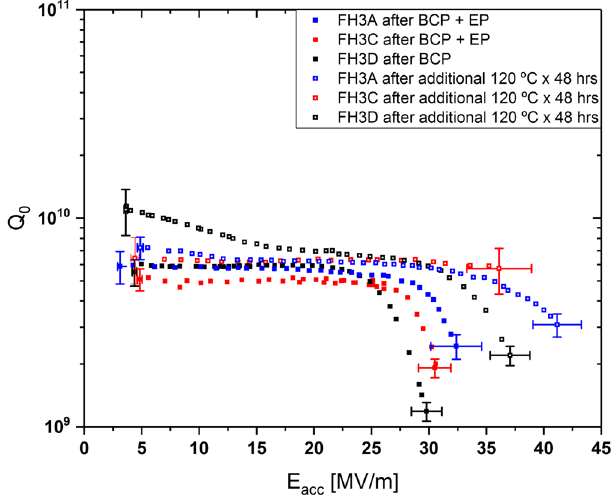
FIG. 9. FH3A, FH3C, and FH3D results before and after mild baking are plotted here. All data is measured at T b ¼ 2 . 0 K. No field emission was observed in any